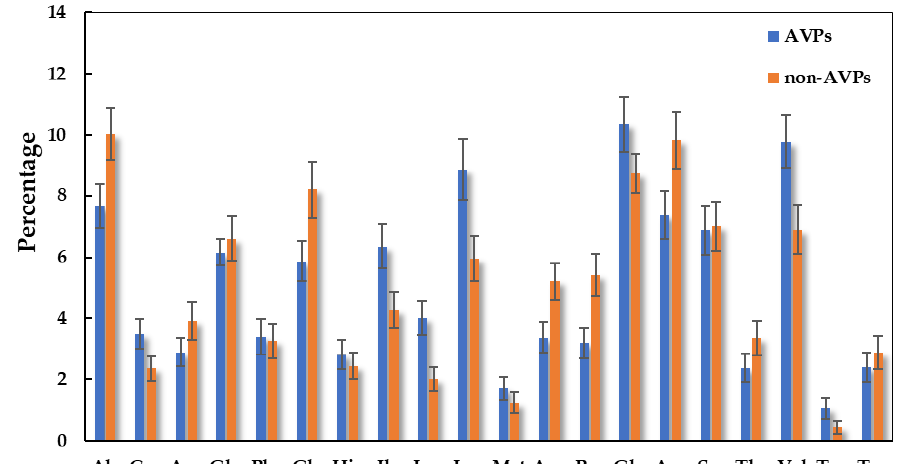
Figure 2. Percentage of the peptides’ properties with respect to their ( a ) length, ( b ) hydrophobicity, and ( c ) net charge based on 71 putative AVPs.